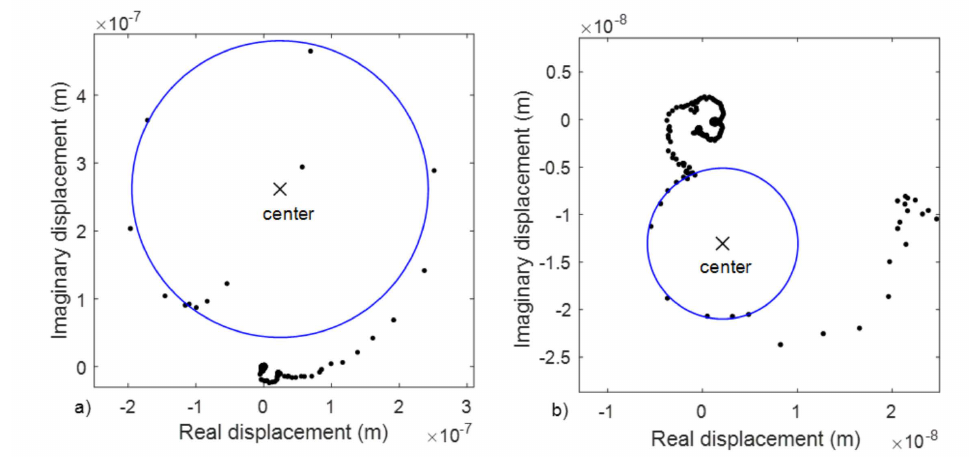
Figure 8. Nyquist diagrams. Application of the circular fit method for two resonance frequencies ( a , b